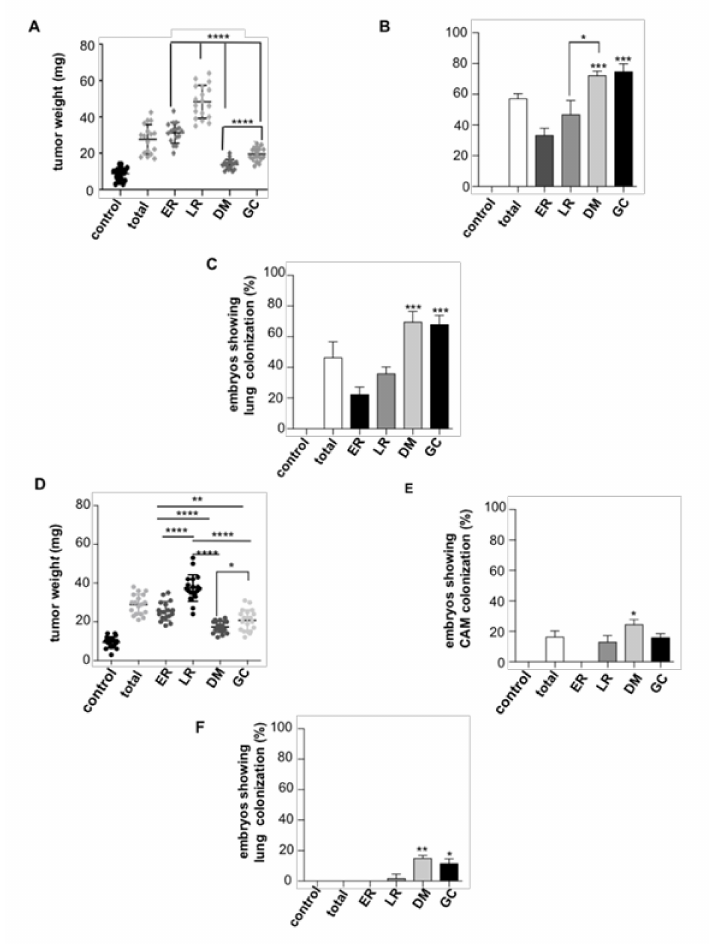
Figure 2. HRAS site-specific e ff ects on tumor growth and dissemination. Cells (10 6 ) from each PCCL3-derived cell line stably expressing the indicated site-specific HRAS V12 constructs were grafted on chick embryos and allowed to grow for seven days. ( A ) Tumor size. ( B ) Intravasation, expressed as the % of chicken displaying distal chorioallantoic membrane (CAM) colonization. ( C ) Distant metastases, expressed as the % of chicken displaying lung colonization. ( D – F ) As before, but refer to PCCL3-derived cell lines expressing the indicated site-specific CDC25 constructs. Data show mean ± SD ( A , D ); mean ± SEM ( B , C , E , F ) from three independent experiments using 9-15 embryos per case. * p < 0.05, ** p < 0.01 *** p < 0.001 and **** p < 0.0001 by two-tailed unpaired Student t